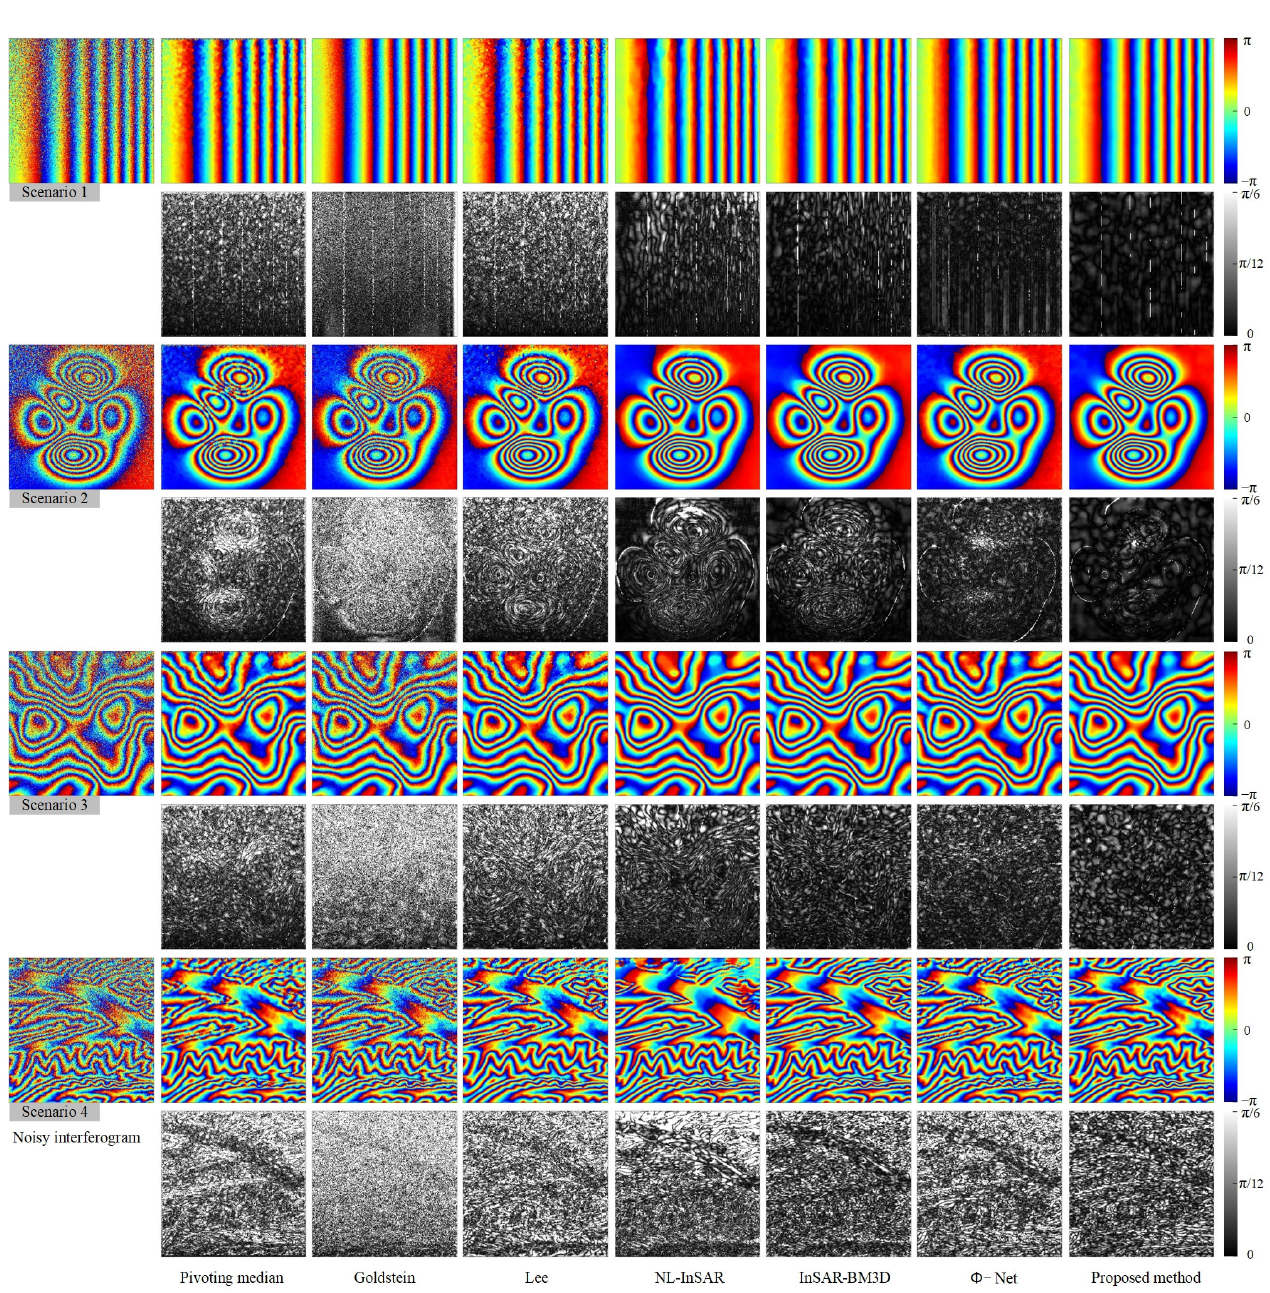
Figure 3. Noisy interferograms and filtered interferograms for the four simulation scenarios. The false color images are the noisy or filtered interferograms, and the black and white images are the phase error images corresponding to the false color image above. The phase error image is the difference image between the filtered and the noiseless interferogram, the white textures in the phase error images represent the error in the phase filtering.